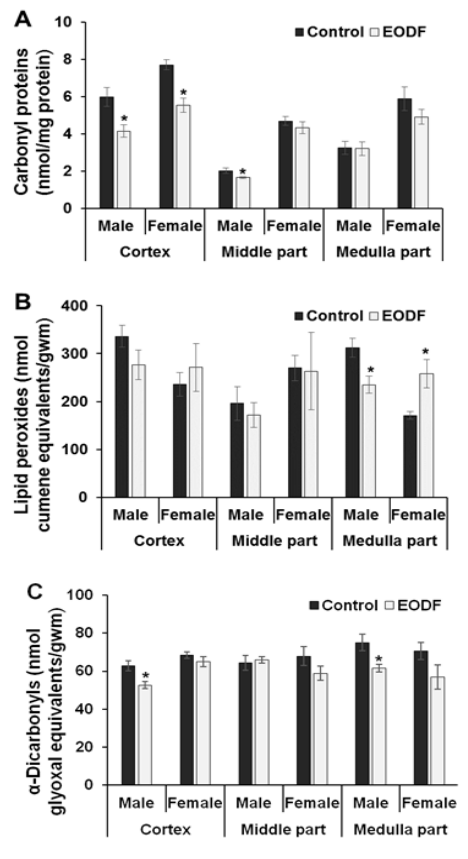
Figure 2: The effect of EODF on the levels of markers of oxidative/ carbonyl stresses in different parts of the brains of young mice: ( A ) carbonyl groups in proteins ( n = 4-6), ( B ) lipid peroxides ( n = 3-6), and ( C ) α-dicarbonyl compounds ( n = 5-6). Data are mean ± SEM. *Significantly different from the corresponding values for the ad libitum fed (control) group, P <